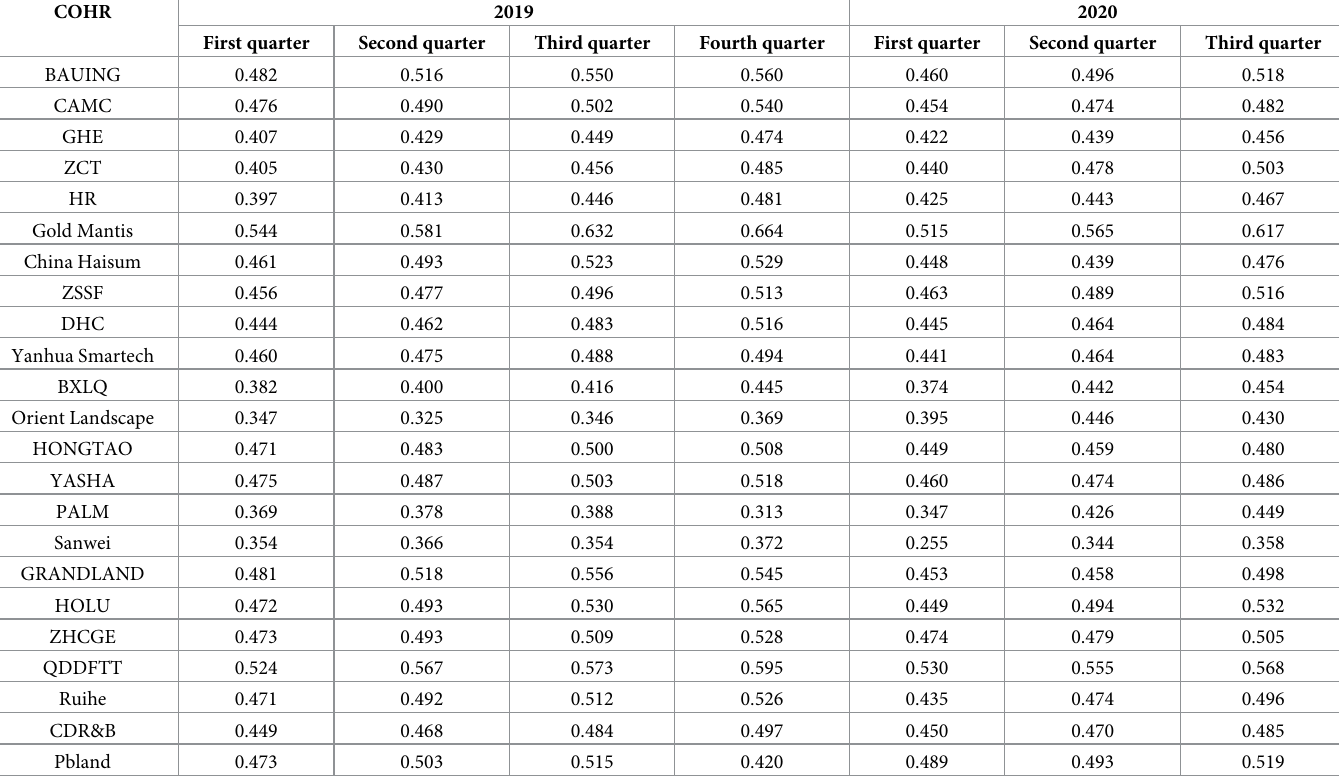
Table 7. Comprehensive score of enterprises in each